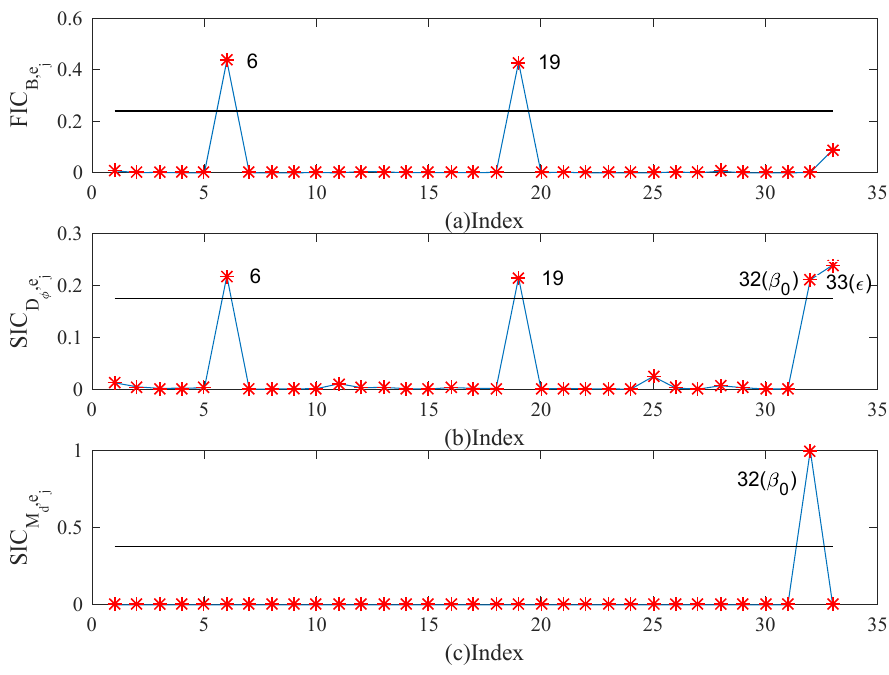
Figure 8. Plots of simultaneous perturbation in the real example. Secondly, the above data are used to illustrate the application of the Bayesian case influence analysis method. We calculated Bayesian case influence measures 𝐷 𝐶𝑀(𝑆) and 𝐶𝑃(𝑆) . The results are presented in Figures 9 and 10. Figure 9a–c demonstrate that cases 6 and 19 were diagnosed as influence points. Figure 10a–c demonstrate that cases 1 and 12 were diagnosed as influence points. As we expected, the results are the same as the previous diagnosis of Bayesian local influence measures.